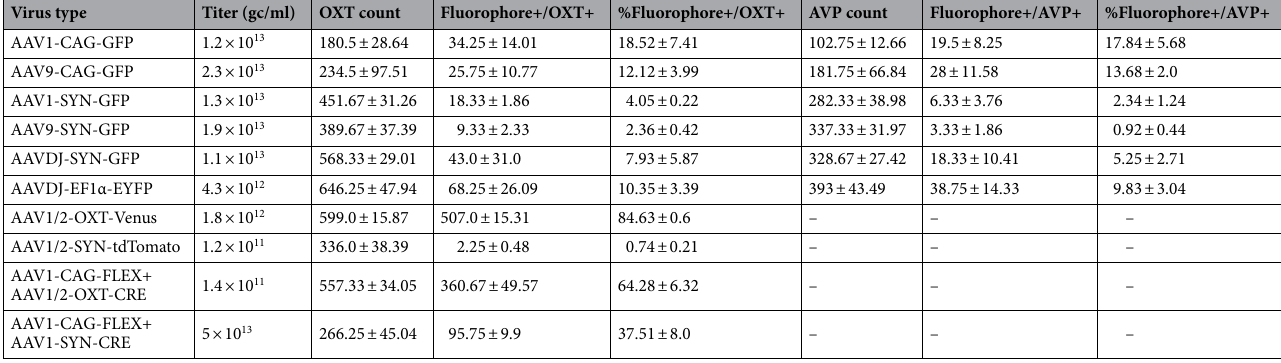
Table 1. Viral titers and counts for